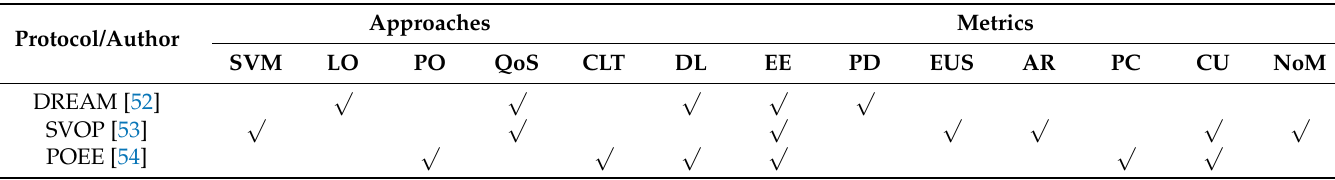
Table 15. Comparative assessment of energy efficient cloud computing